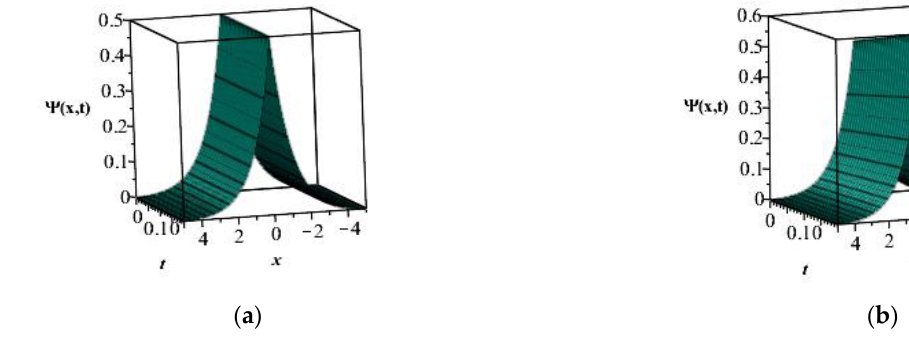
Figure 5. The solution plots of CH equation at α = 1 ( a ) two-terms FRDTM solution ( b ) homotopy perturbation method (HPM) solution [28]. Table 2. The two term FRDTM approximation results of CH equation with HPM [28] for 1 = .